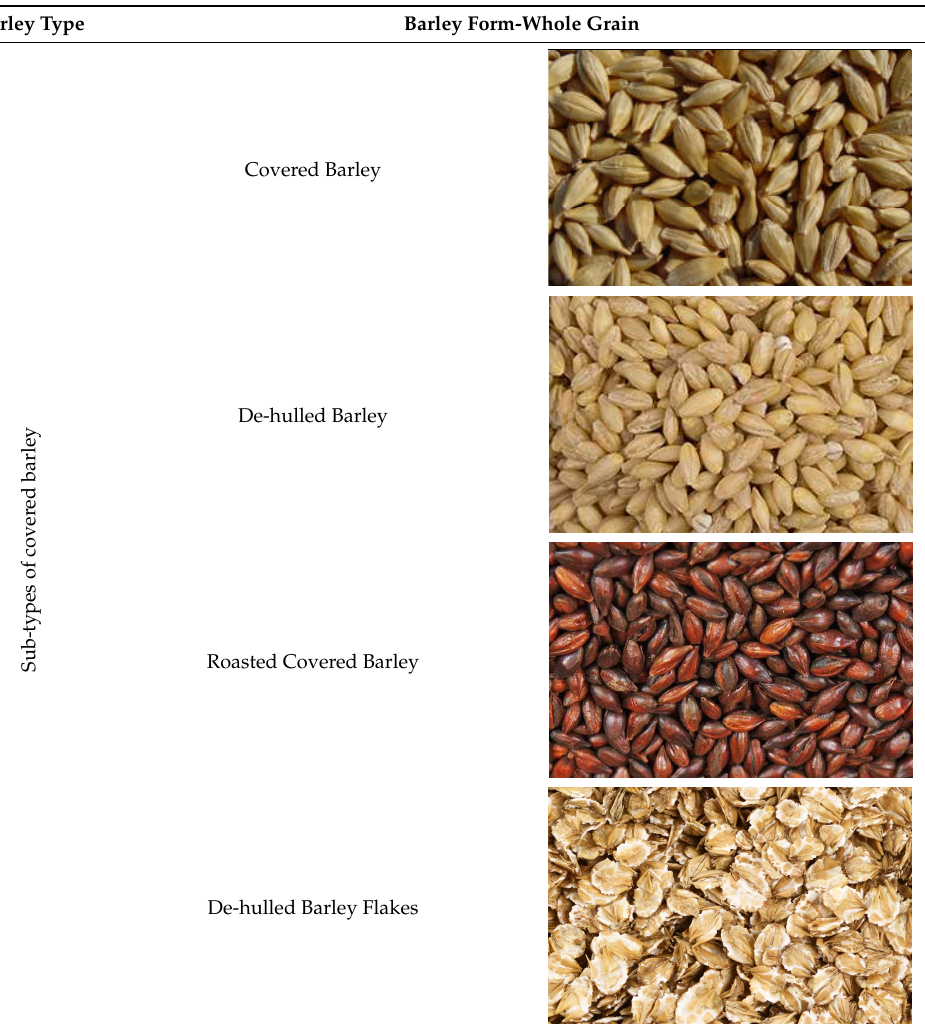
Table 1. Various forms of barley on the market.